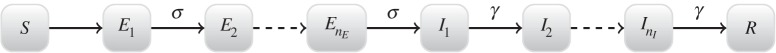
Erlang SEIR model.